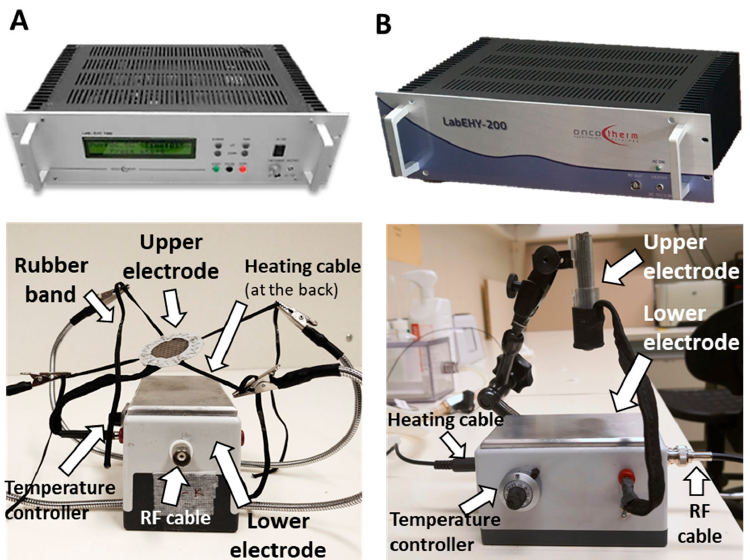
Figure 11. Modulated electro-hyperthermia small animal treatment device. ( A ) LabEHY-100 device and the treating setup: temperature-controlled (heated) lower electrode and tissue electrode (upper electrode). ( B ) LabEHY-200 device and the newly developed treating setup: temperature-controlled